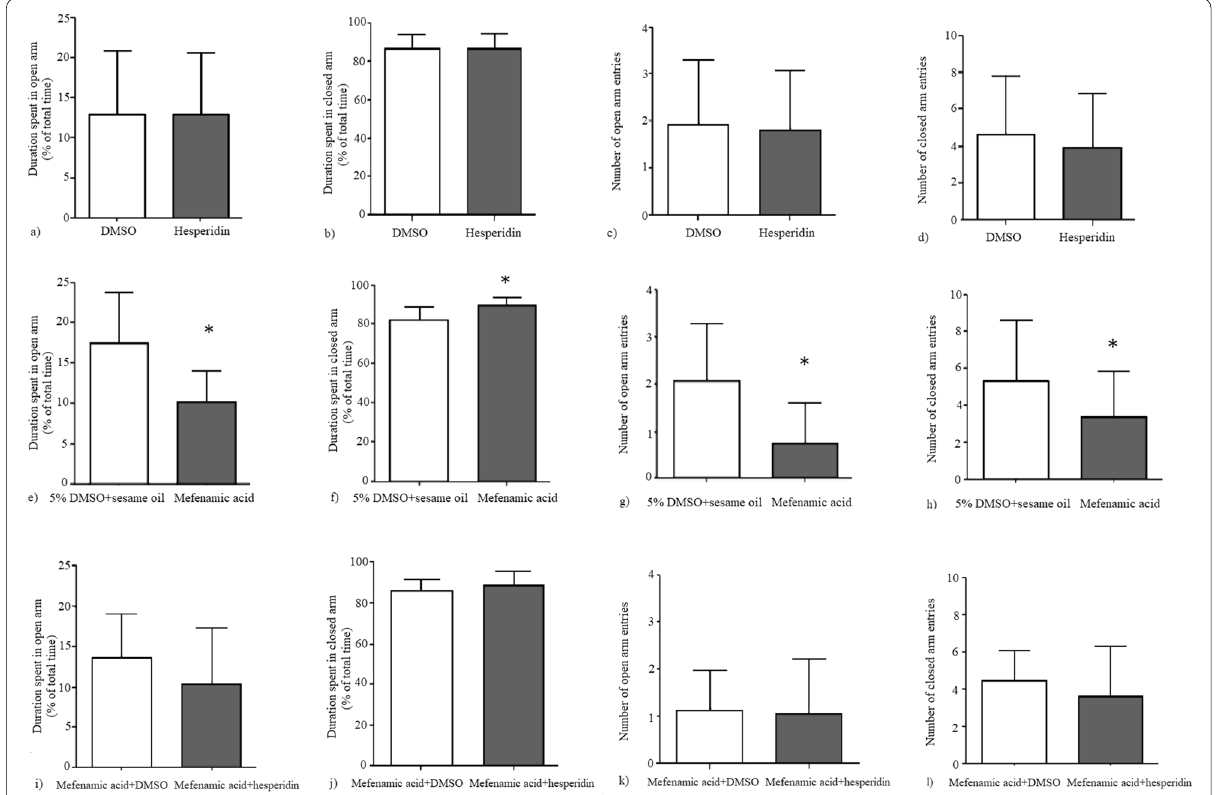
Fig. 7 In elevated plus maze test, a ) duration spent in open and b ) closed arms ( p and d ) closed arm entries were similar between hesperidin and DMSO groups ( p was lower ( p 0.003) and f ) duration spent in closed arms was higher ( p = number of closed arm entries were similar (